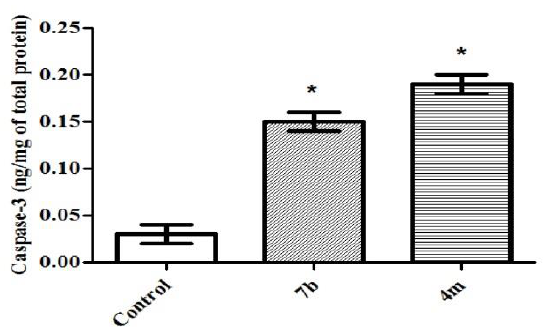
Figure 3. Effect of compounds 4m and 7b on the protein levels of caspase-3 in MDA-MB-231 cells treated with the compounds at their IC 50 concentrations against control (1% DMSO). Data are mean ± S.D. ( n = 3). The experiments were done in triplicate. * Significantly different from control at p < 0.05.